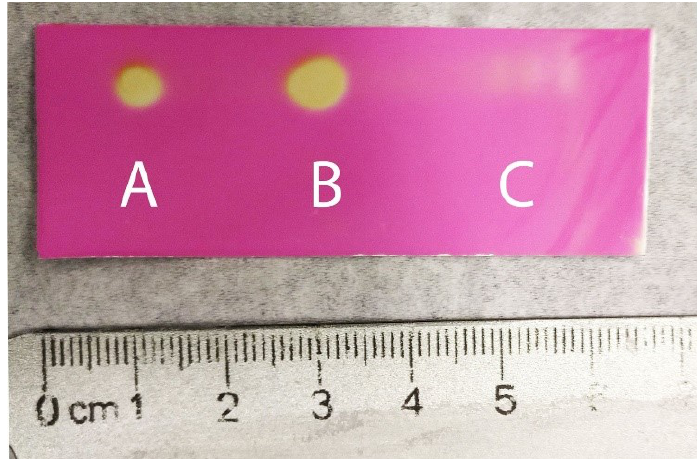
Figure 5. Thin-layer chromatography showing (A) ox-DTT, (B) tert-butyl 3-(DTT)propanoate, and (C) hydrophobic products.